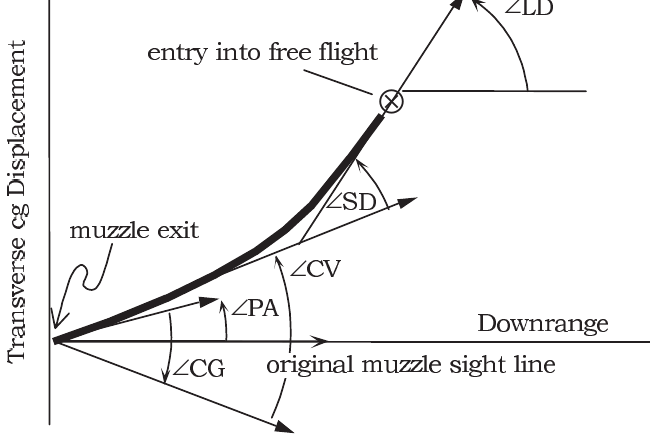
Fig. 1. Hypothetical planar CG motion of a KE rod caused by launch disturbances.